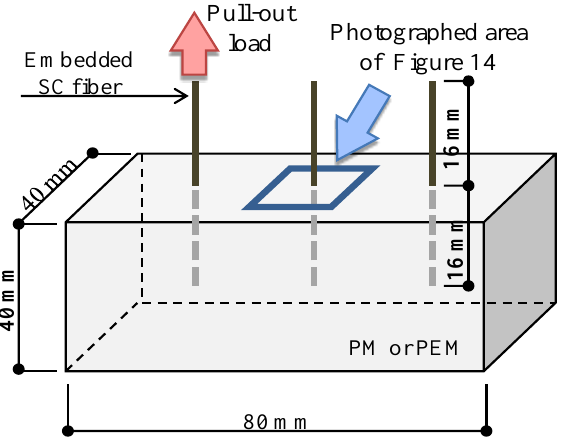
Figure 13. Specimen used for single fiber pullout